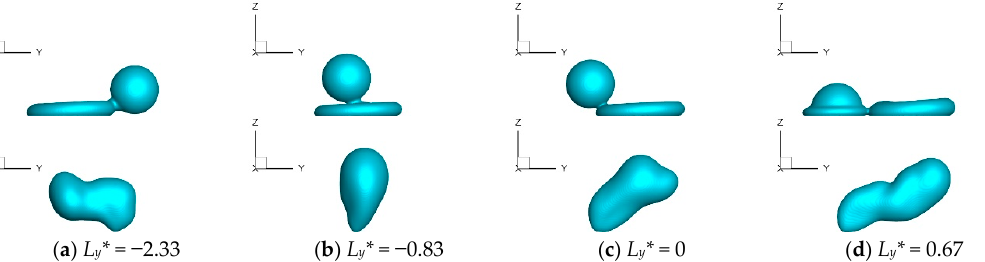
Figure 13. The different droplet morphology at various L y *. The first line is the moment that two droplets connect, and the second line is the moment that they rebound from the surface.